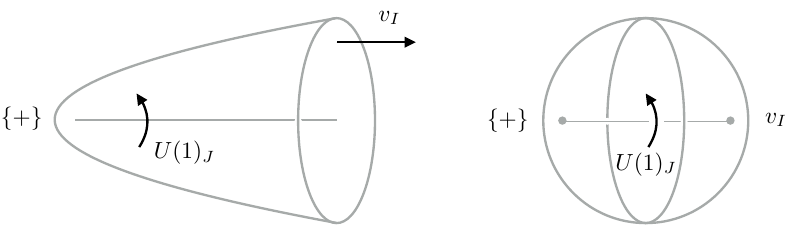
Figure 8. We consider the vortex partition function on a cigar with U(1) v I at in(cid:12)nity. This can also be viewed as a sphere with a (cid:12)xed vacuum at where ~ q = ( 1) N q . The integrand has poles at (cid:27) = m j (cid:0)